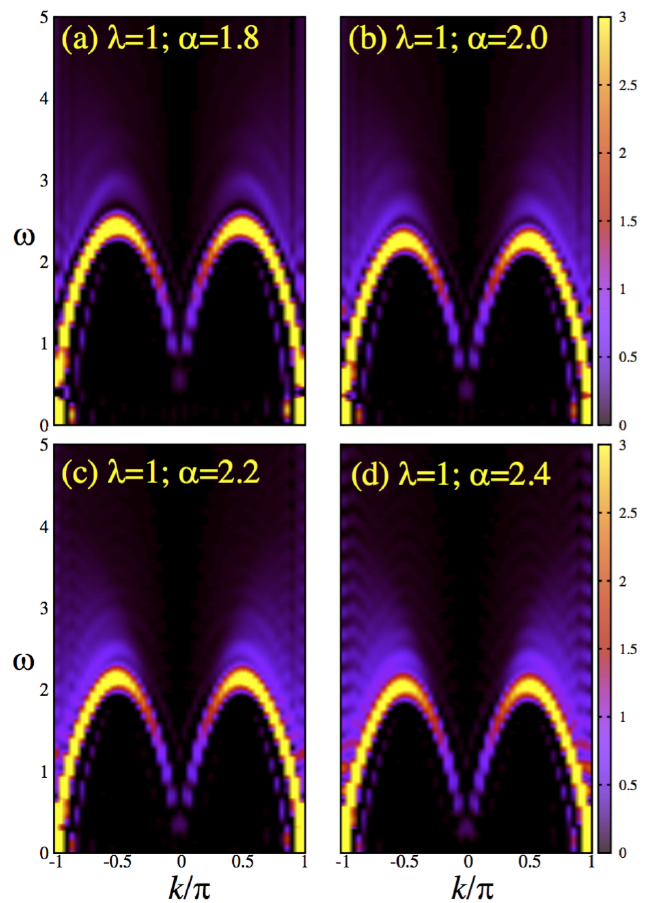
Figure 2: Momentum resolved dynamic structure factor S z ( k , ω ) of the Heisenberg chain with long range interactions, λ = 1, and different values of α across the phase